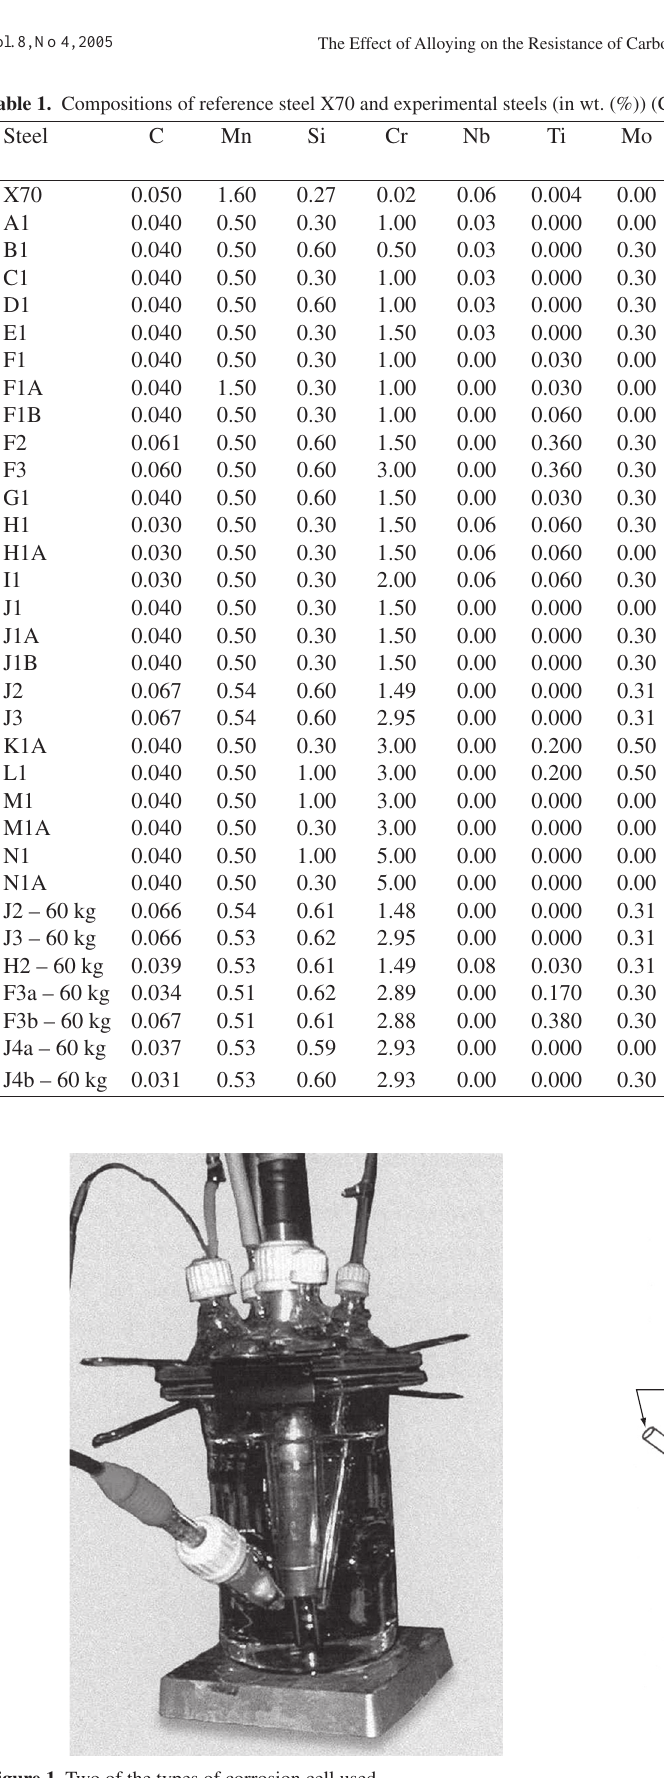
Figure 1. Two of the types of corrosion cell